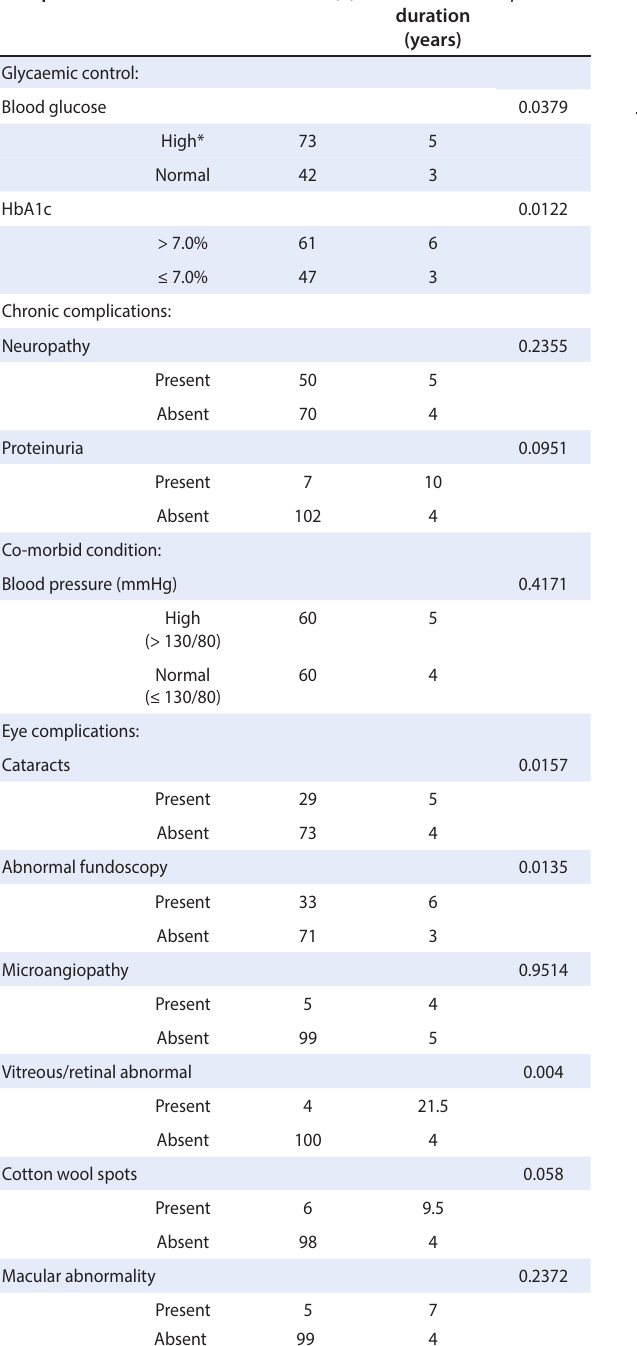
Table 2: Relationship between diabetes mellitus (DM) complications and patients’ duration of DM